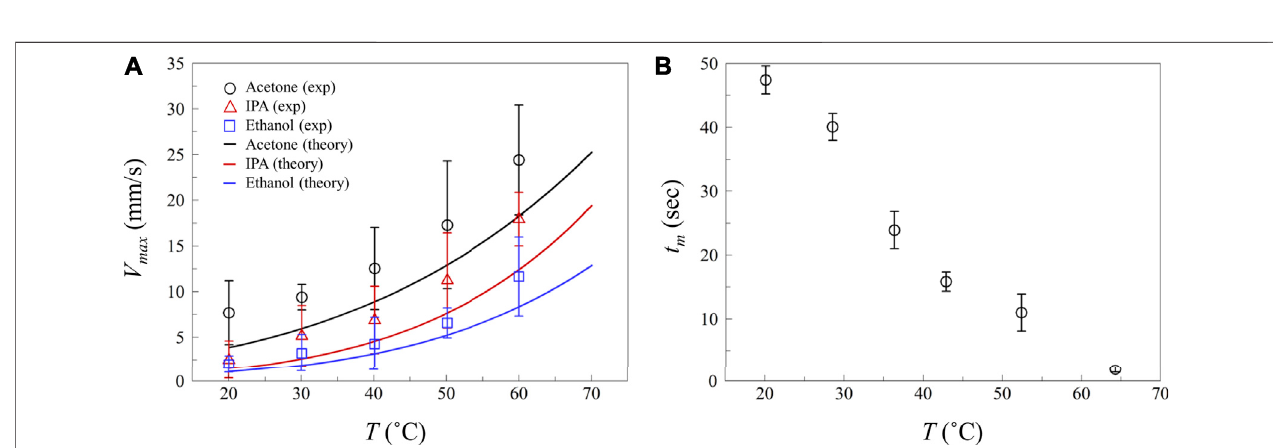
FIGURE 5 | (A) The maximum solutal Marangoni velocity ( V max ) as a function of the temperature of three volatile liquids of acetone (black), IPA (red), and ethanol (blue), which was estimated by the PIV experiments (symbols) and theoretical estimation (solid lines). (B) The time required for complete digital micro fl uidic mixing ( t m ) of water as a function of the volatile liquid (acetone)